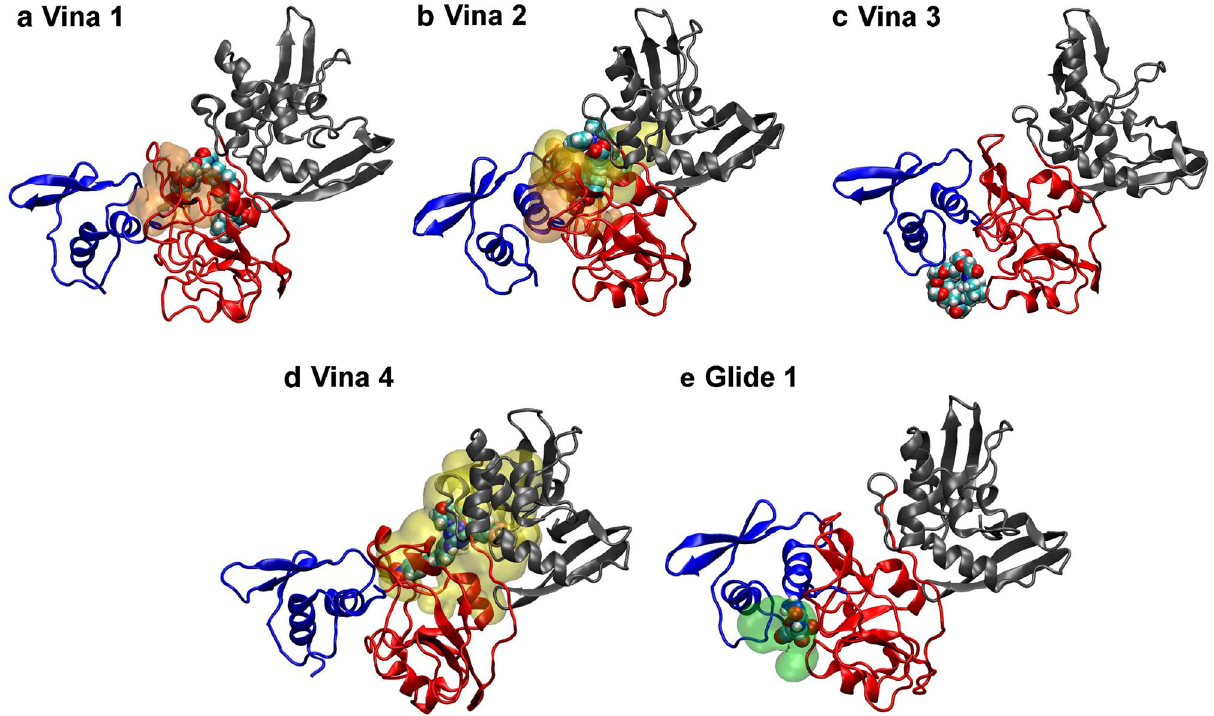
Figure 6. Complex structures of the top poses. ( a–d ) The top 4 poses identified by AutoDock Vina 28 and ( e ) the top pose identified by Schrödinger Glide 33 . Representative complex structures after free 100 ns MD are shown except for ( b ), in which the output of AutoDock Vina is